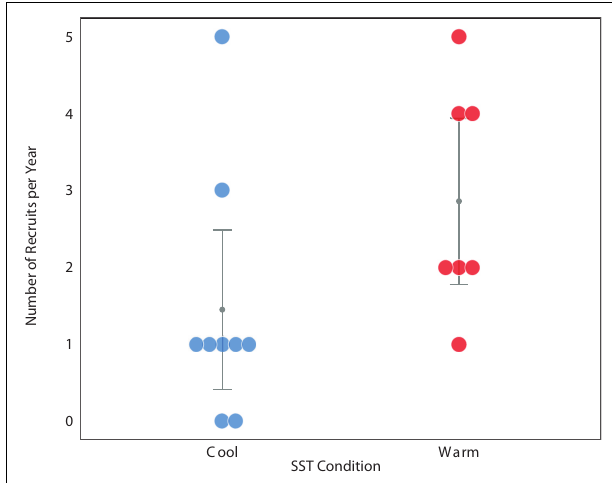
FIGURE 3 | Relative number of annual juvenile loggerhead sea turtle recruits during years of cool (blue) and warm (red) regional ocean conditions in the eastern North Pacific Ocean study area ( Figure 1B ) between 1997–2012, n = 33. Raw data values are shown with color dots. Error bars and dark circle represent the grouped median and standard